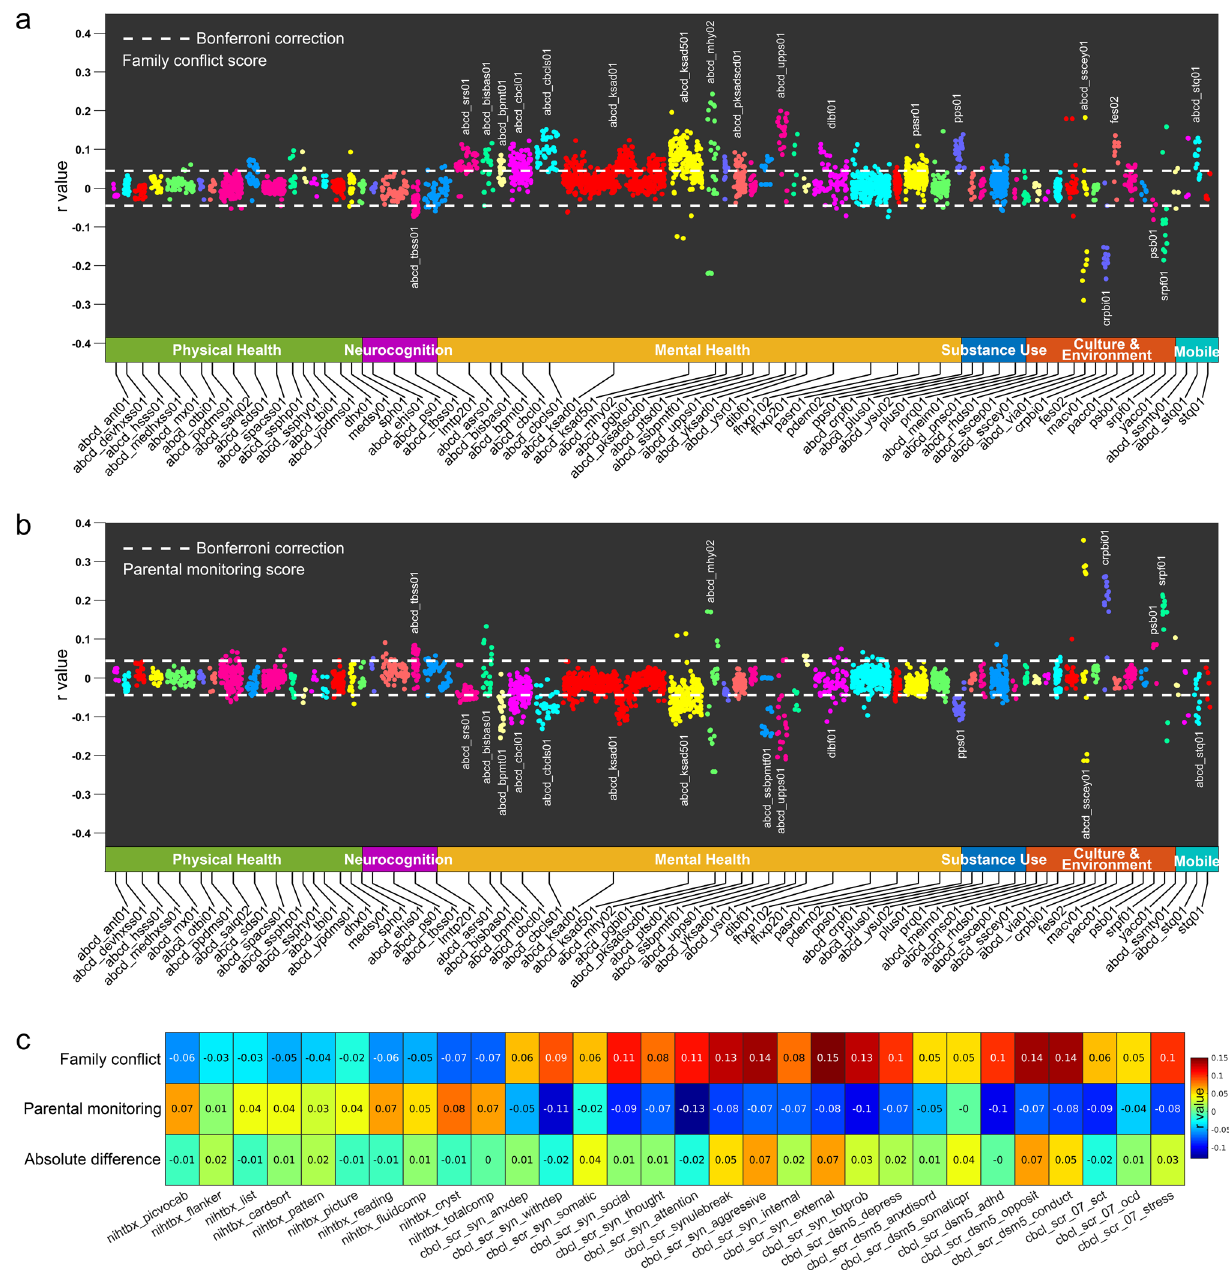
Fig. 1 Behavior-level correlation analysis. a Correlation between the family con fl ict score and behavioral measures in the ABCD. The behavioral measures most associated with family con fl ict relate to mental health. The behavioral measures and corresponding abbreviations are de fi ned in the “ Methods ” section and Table S1. b Correlation between the parental monitoring score and behavioral measures in the ABCD. c Correlation of the family con fl ict (row 1) and the parental monitoring score (row 2) with the cognitive and behavioral scores. Row 3 shows the absolute difference of the correlation between rows 1 and 2. All measures were signi fi cantly correlated with the family con fl ict score except nihtbx_ fl anker, nihtbx_list, and nihtbx_picture and all measures were signi fi cantly correlated with the parental monitoring score except nihtbx_ fl anker, nihtbx_pattern, cbcl_scr_syn_somatic, and cbcl_scr_dsm5_somaticpr (Bonferroni correction, p <